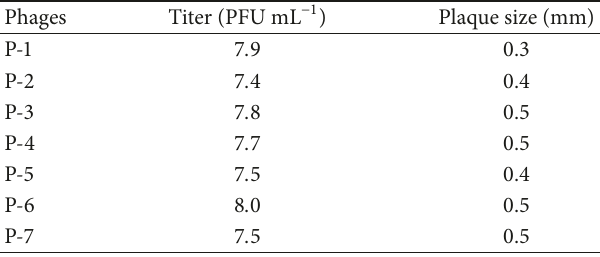
Table 2: Titer (PFU mL −1 ) and plaque size (mm) of isolated phages.